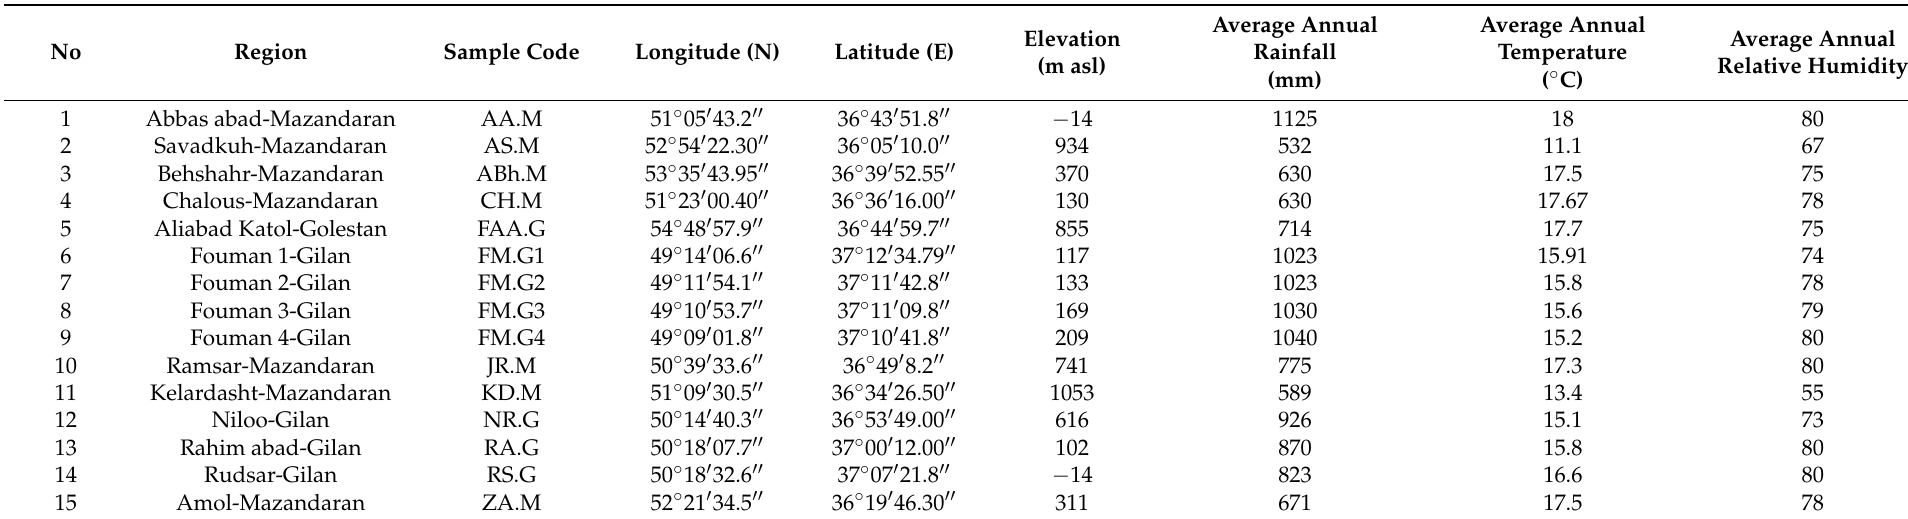
Table 1. Geographical information of sampling sites for M. aquatica plants from the Hyrcanian hotspot of